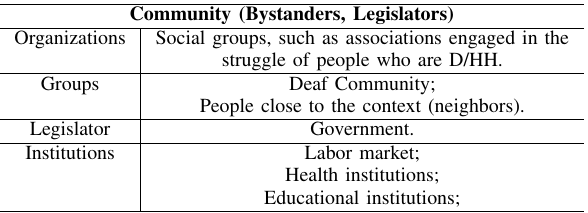
TABLE XI C ATEGORIZATION OF STAKEHOLDERS IN THE C OMMUNITY CIRCLE Community (Bystanders, Legislators)